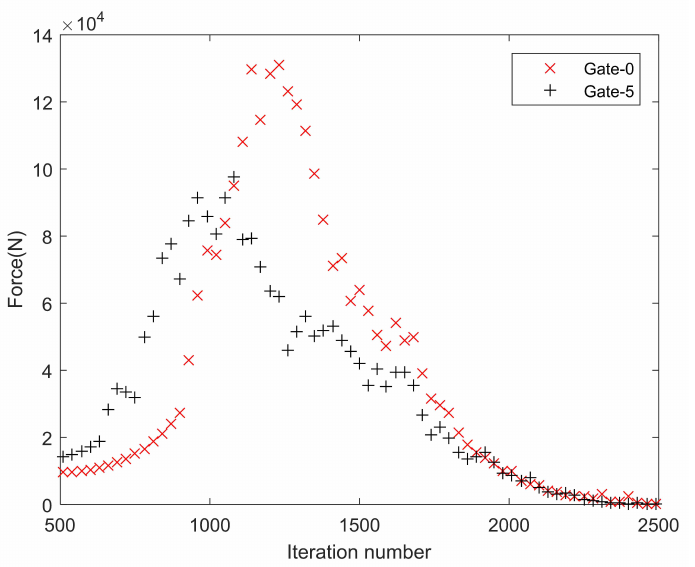
Figure 7. Changes in the resultant force of pedestrians between pedestrians in different situations over